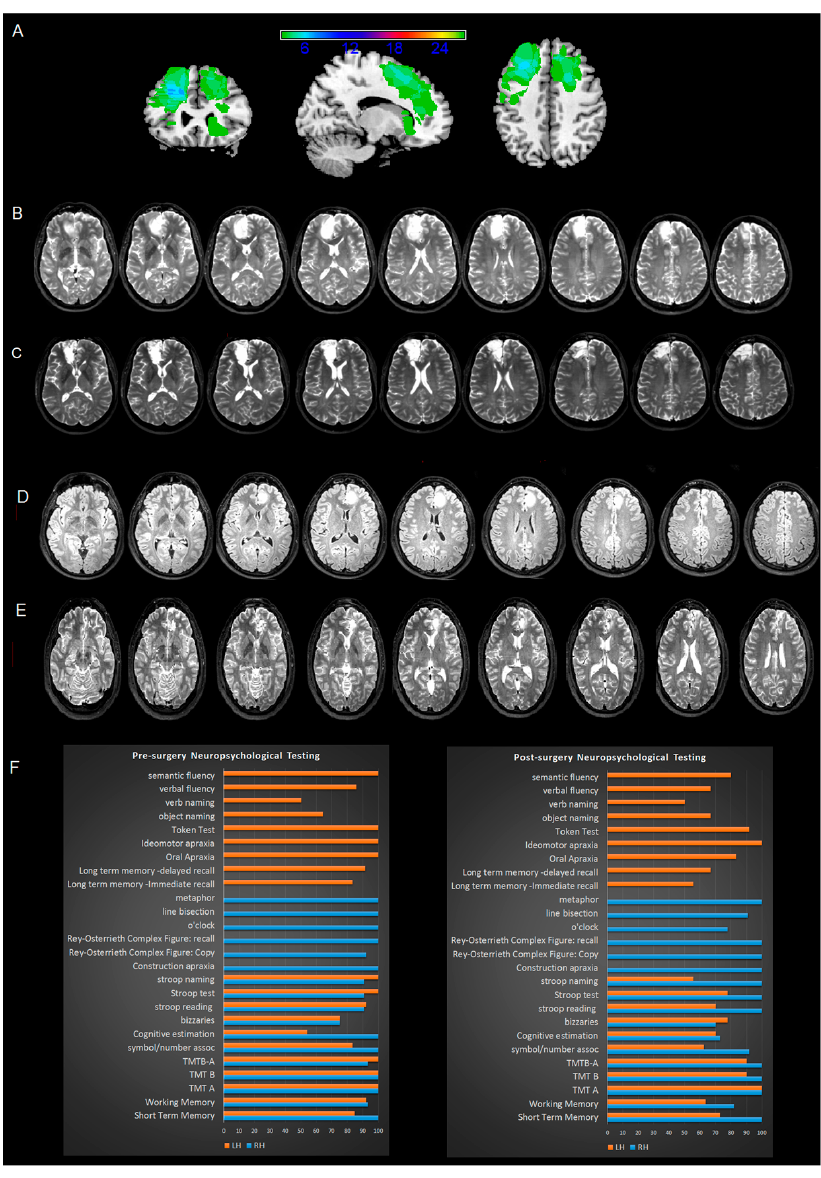
Figure 1. Patients’ lesion volumes of interest (VOIs) overlay ( A ) in addition to pre-surgery ( B , D ) and